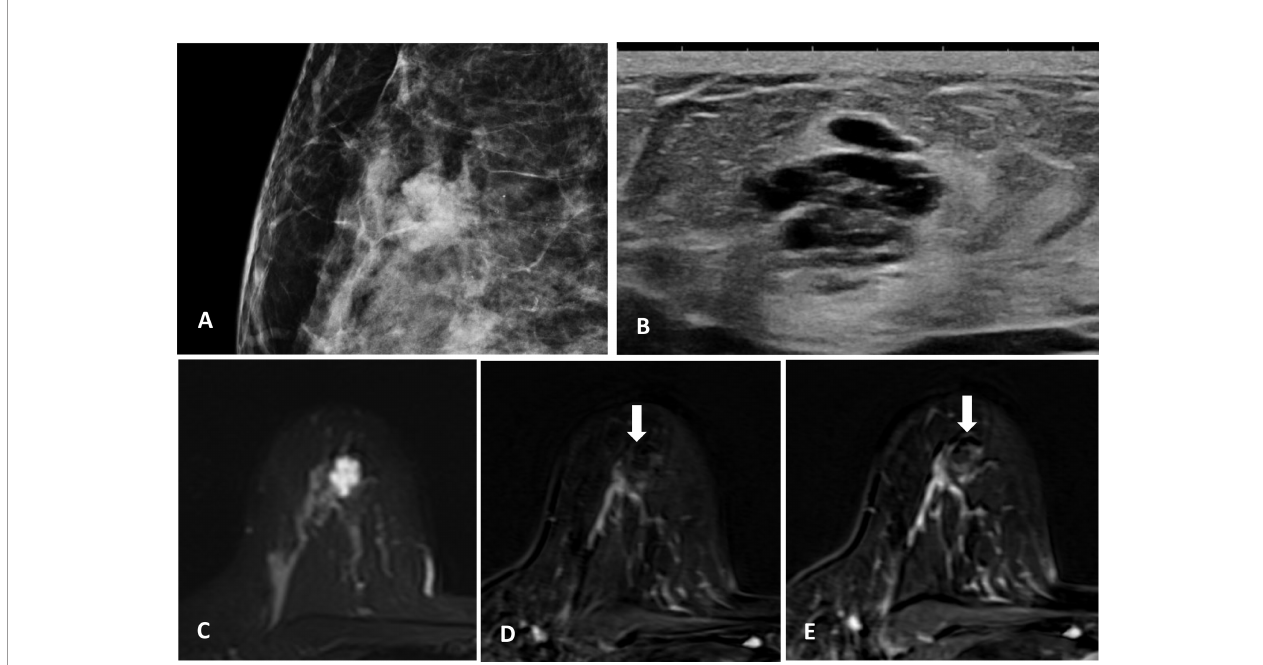
FIGURE 1 | (A) Irregular high-density mass with microlobulated margins on mammography, no calci fi cation within the lesion. (B) Heterogeneous irregular mass with circumscribed margins on ultrasound. (C) MR T2-weighted sequence, the lesion is lobular and shows high signal intensity. (D, E) MR-enhanced T1-weighted sequence (immediately after contrast injection and about 6 min delay), the lesion shows persistent slight enhancement at the periphery with no internal